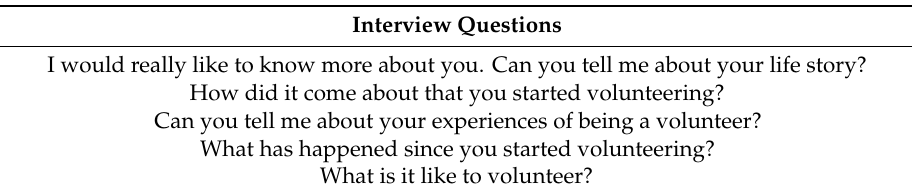
Table 2. Thematic interview